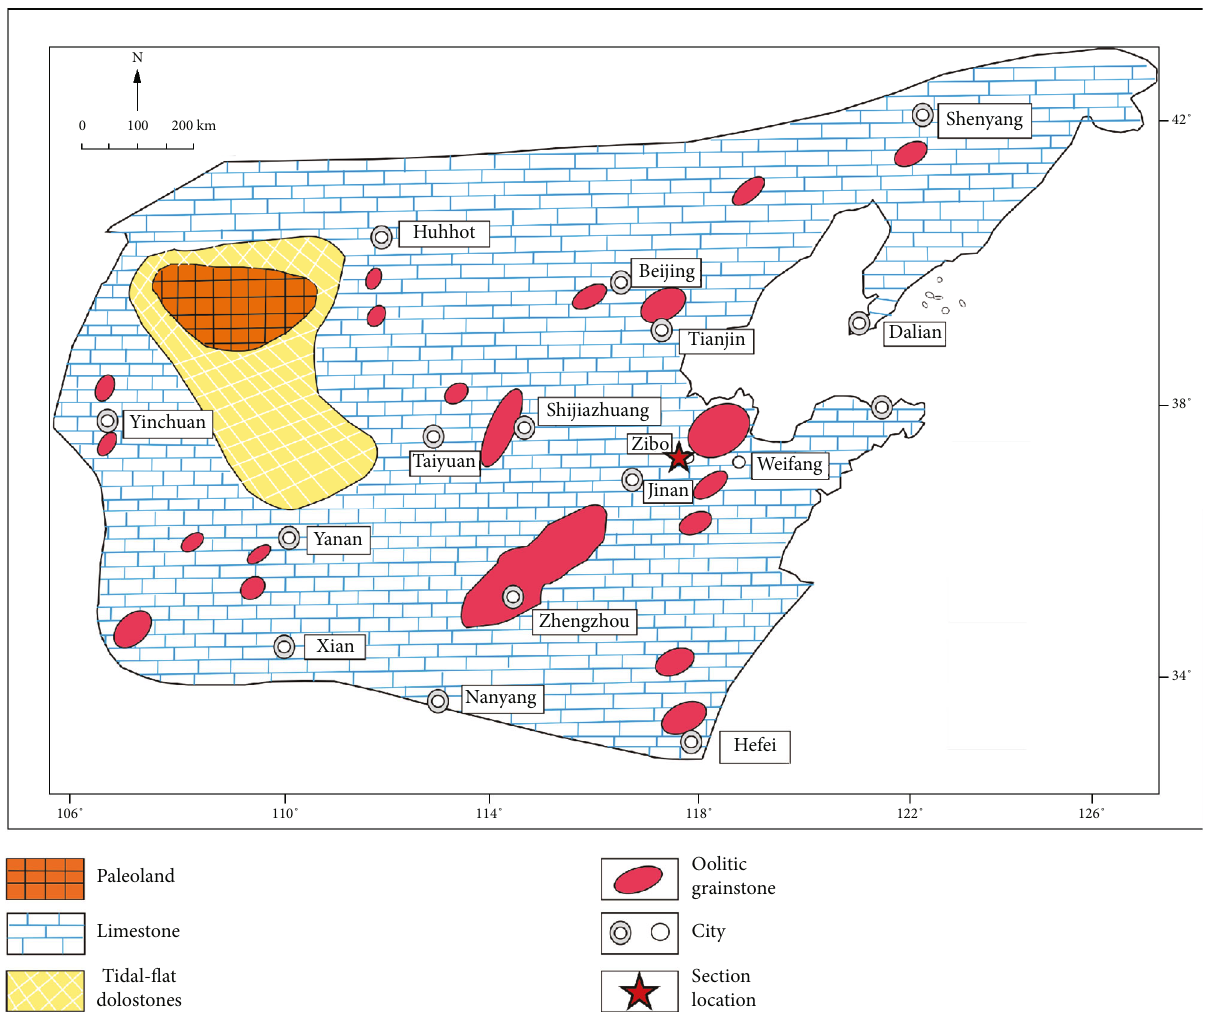
Figure 1: Platform Cambrian Miao Ling paleogeographic map of North China platform (revised according to